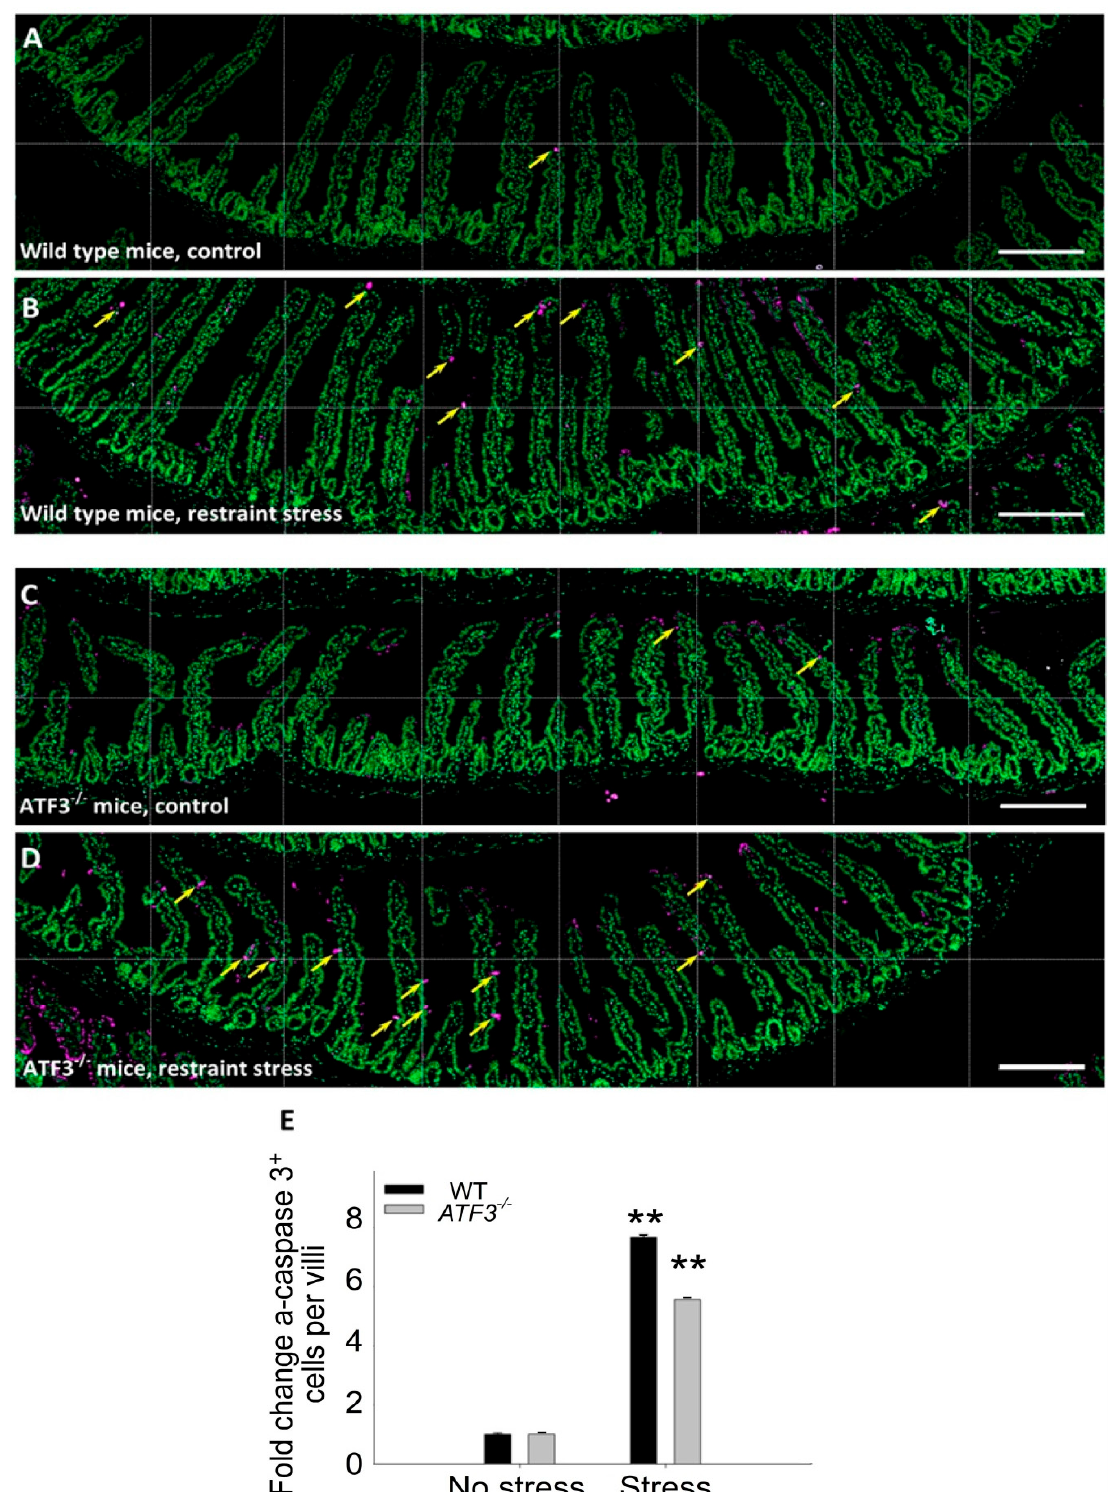
Figure 10. Relative activated ‐ form caspase 3 staining signals in WT and ATF3 − / − mice after stress. The WT mice ( A , B ) was compared to ATF3 − / − mice ( C , D ) without ( A , C ) and with ( B , D ) restraint stress. ( E ) The quantitative results of activated ‐ form caspase ‐ 3 + (a ‐ caspase 3 + ) apoptotic epithelial cells and villi were obtained from three images at various areas. ** p < 0.01 vs. the respective no stress groups. Scale bars: 200 μ m ( A – D ). Error bars show the standard deviation.